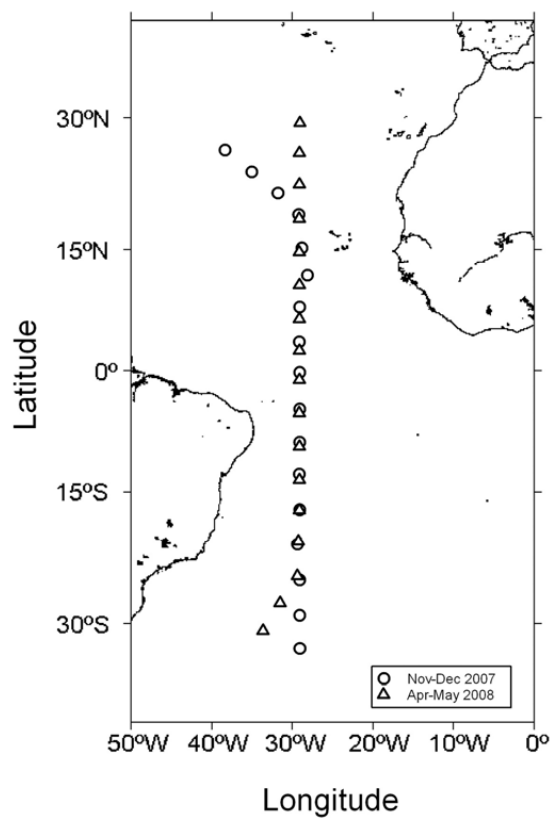
Fig. 1. Map showing the 2007 (a) and 2008 (b) TRYNITROP cruise tracks. The cruises took place during 16 November–16 Decem- ber 2007 and 8 April–6 May